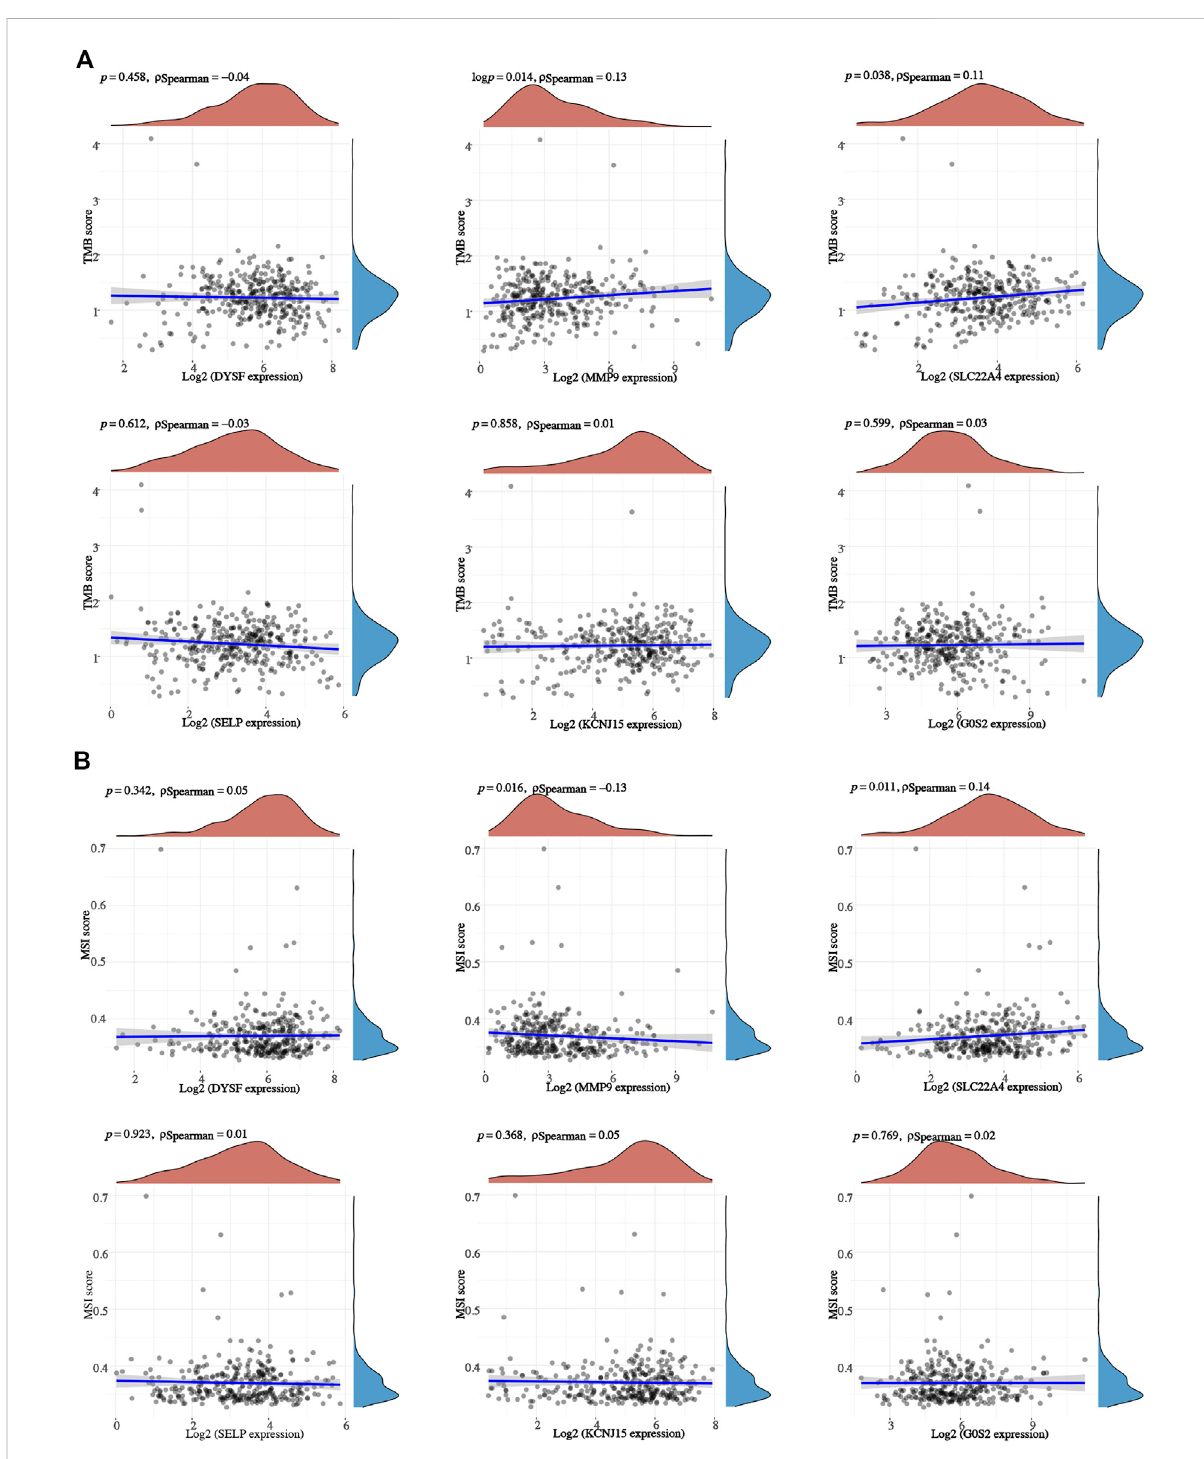
FIGURE 8 TMB/MSIanalysis ofprognosticsignaturegenesinccRCC.Thecorrelationbetweenprognosticsignaturegene expression andTMB (A) /MSI (B) score in ccRCC. ccRCC, clear cell renal cell carcinoma; TMB, tumor mutational burden; MSI, microsatellite instability